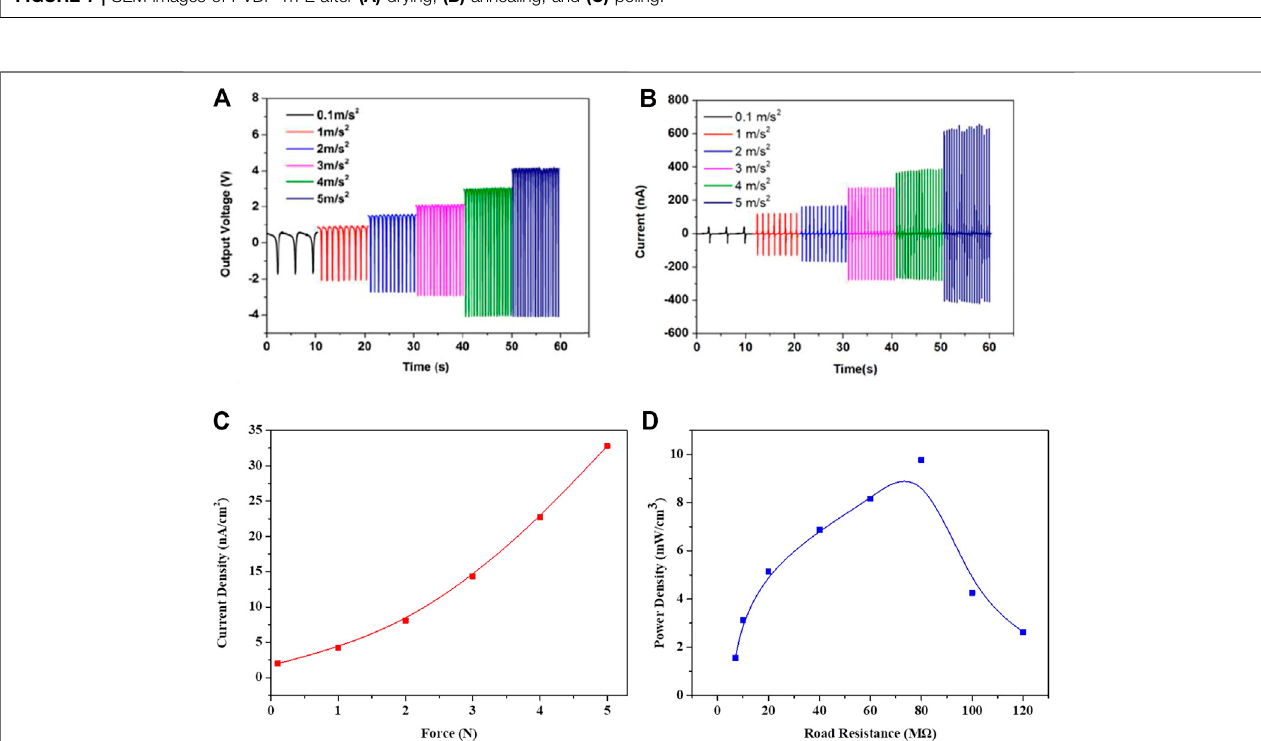
FIGURE 8 | (A,B) Output voltage and current of the PVDF-TrFE fi lm under linear motor impact with different accelerated speeds. (C) Graph of the relationship between current density and applied stress. (D) The curves between power density and load resistance.